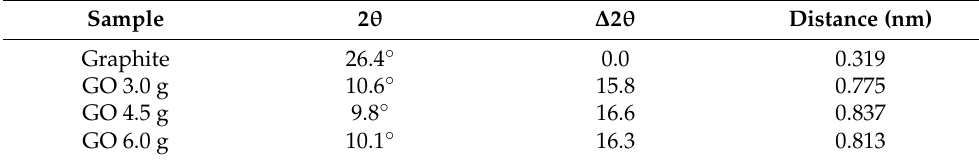
Figure 2. ( a ) XRD profile for GO 3.0 g, GO 4.5 g and GO 6.0 g samples. ( b ) XPS survey spectra of graphite and GO 4.5 sample. Table 1. 2 θ values of graphite and GO produced, and its interplanar distances. Sample